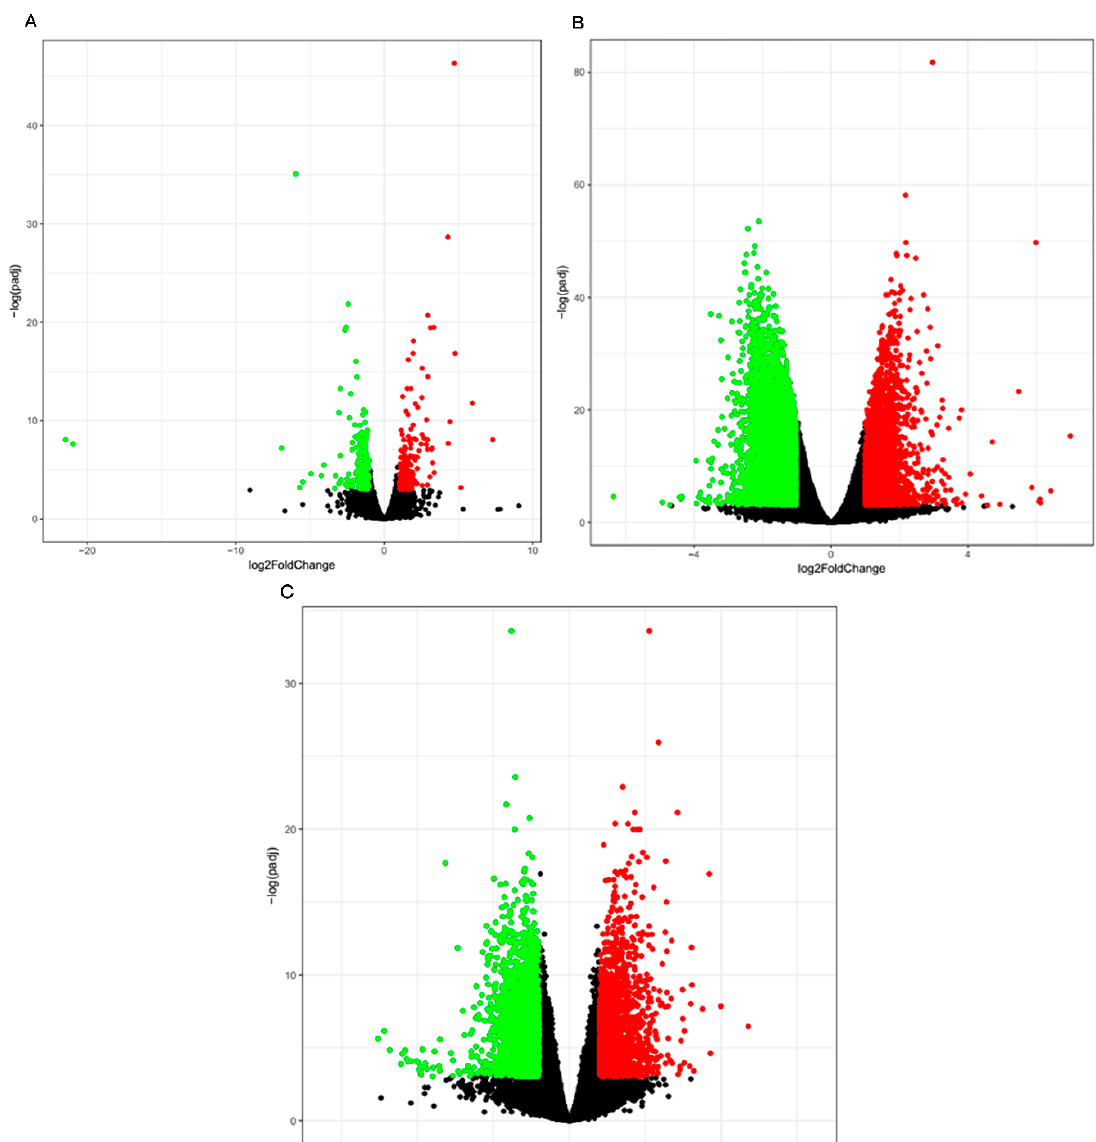
Figure 3. Volcano plot displaying the DEGs in horse testicular tissue. Red dots: upregulated genes. Green dots: downregulated genes. ( A ) DEGs between Guanzhong and Chakouyi horses. ( B ) DEGs between DTs and UDTs of cryptorchids. ( C ) DEGs between DTs of normal horses and UDTs of cryptorchids.